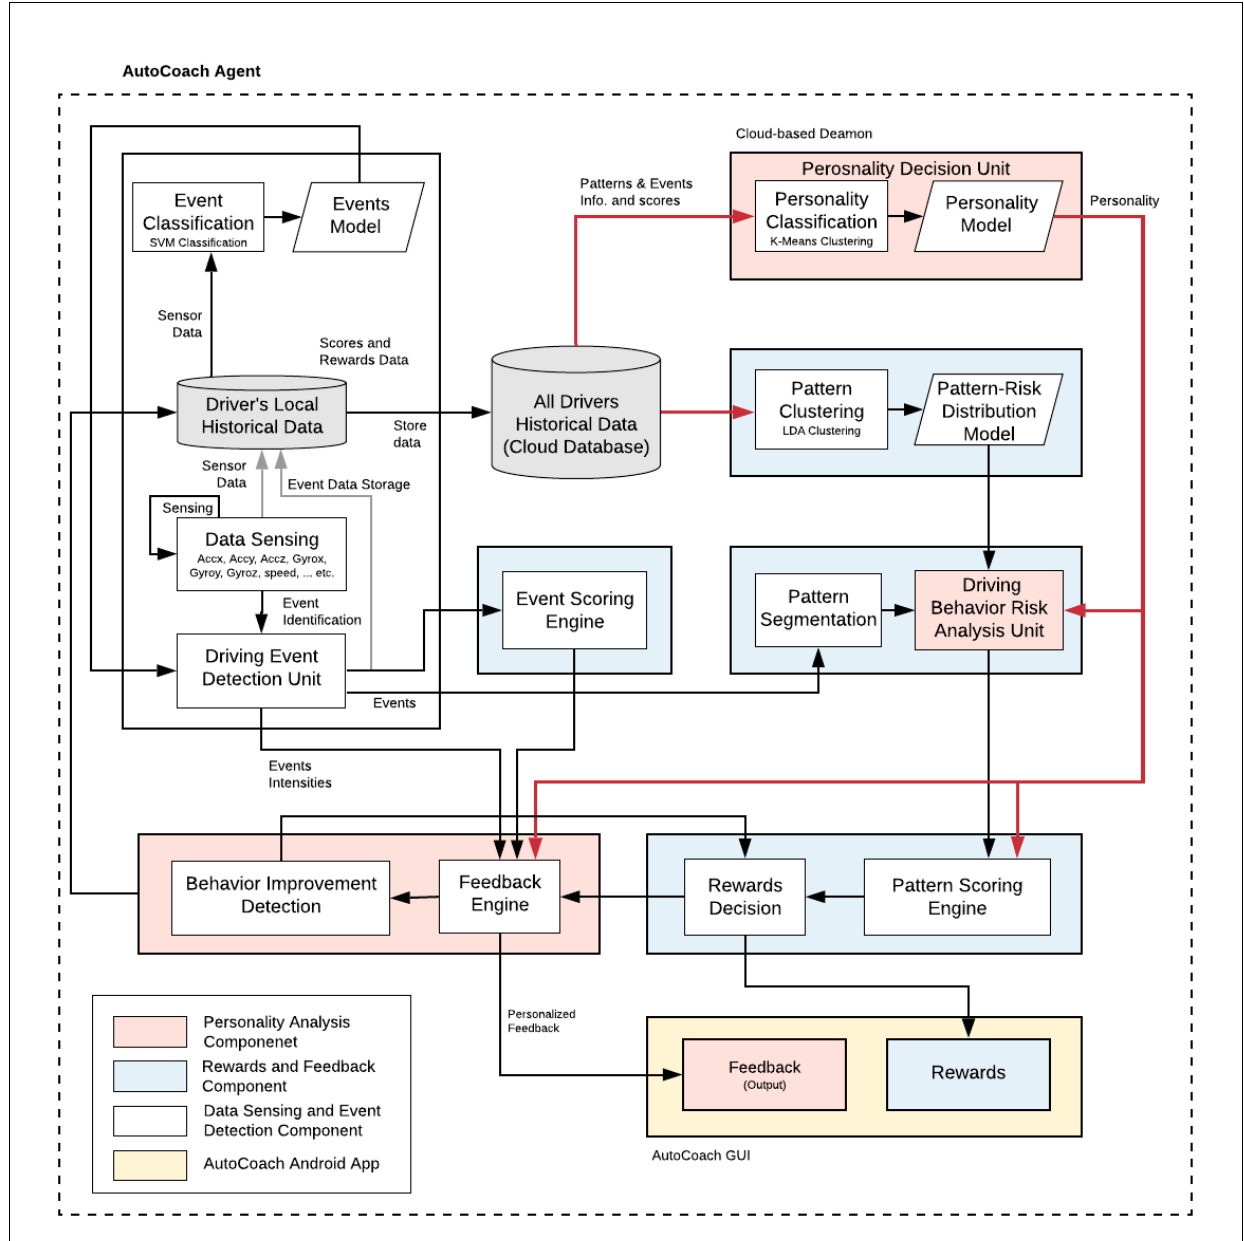
Figure 2. AutoCoach’s functional